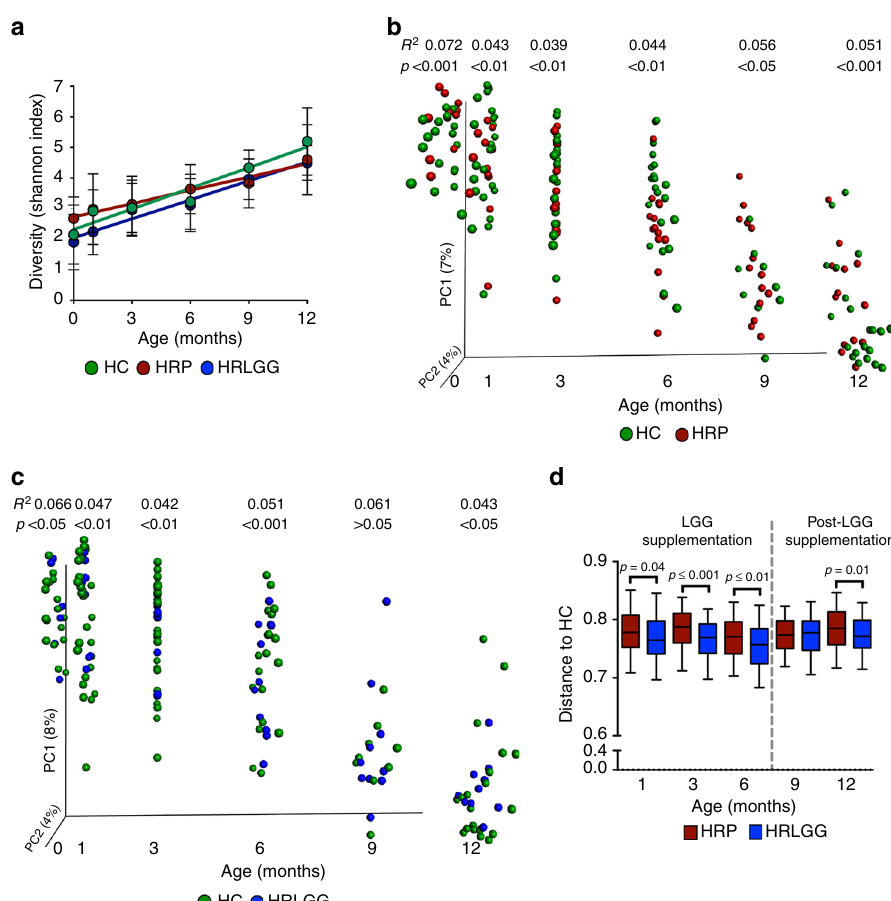
Fig. 1 Gut microbiota maturation of high risk for asthma (HR) subjects is signi fi cantly distinct from that of healthy controls (HC), and in fl uenced by oral Lactobacillus rhamnosus (LGG) supplementation. a Compared to HC ( n = 29) subjects, HR placebo supplemented (HRP; n = 15) participants exhibit a signi fi cant delay in bacterial alpha diversi fi cation over the fi rst year of life ( β ANCOVA, p = 0.02), which is partly rescued by LGG supplementation (HRLGG; n = 10; β ANCOVA, p = 0.63). Error bars indicate standard-deviation from the mean. b HRP ( n = 15) and c HRLGG ( n = 10) infants exhibit signi fi cant differences in bacterial beta diversity across all of the time points assessed (Unweighted UniFrac distance; R 2 and p -values calculated using PEMANOVA). d HRLGG ( n = 10) infant gut microbiota is signi fi cantly (though marginally) more similar to HC ( n = 29) subjects during the period of LGG supplementation (Unweighted UniFrac distance; Bonferroni corrected t -test). Whiskers extend to 95% con fi dence